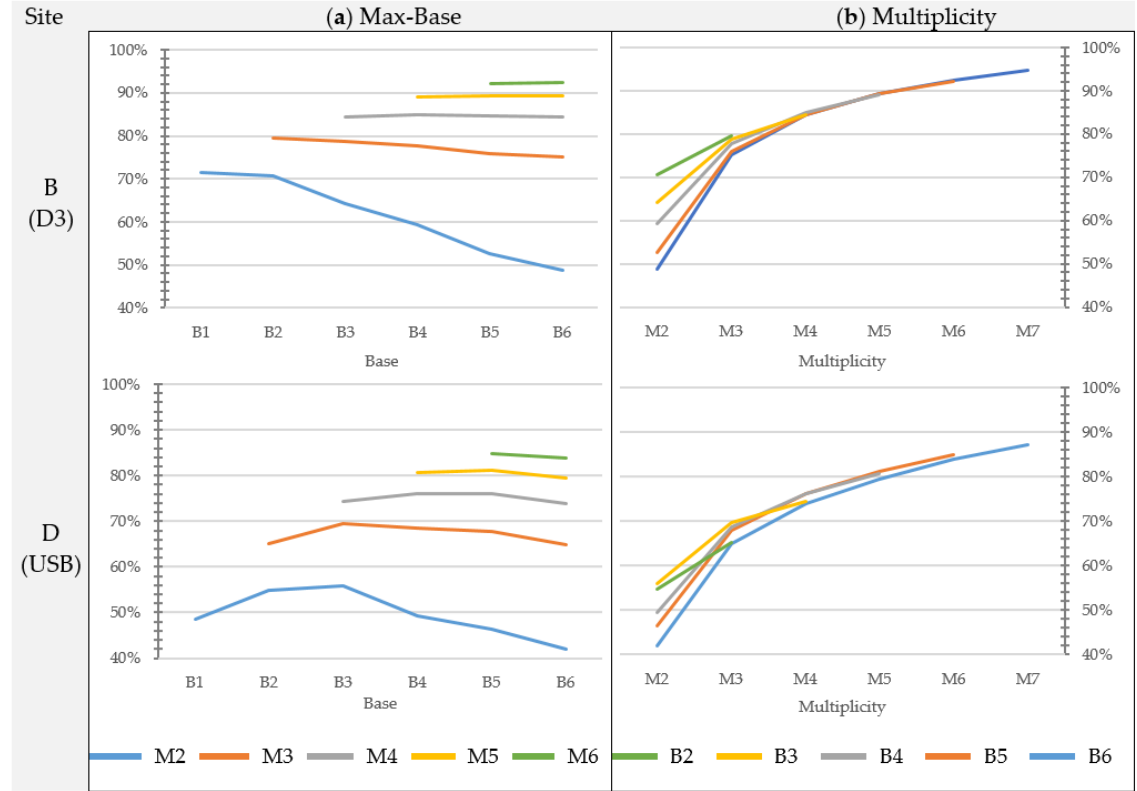
Figure 13. Graphs showing the DEM completeness in percent for Sites B and Site D using the Nikon D3 and USB, respectively: ( a ) the influence of max ‐ base variability and ( b ) the influence of Nikon D3 and USB, respectively: ( a ) the influence of max-base variability and ( b ) the influence multiplicity. of